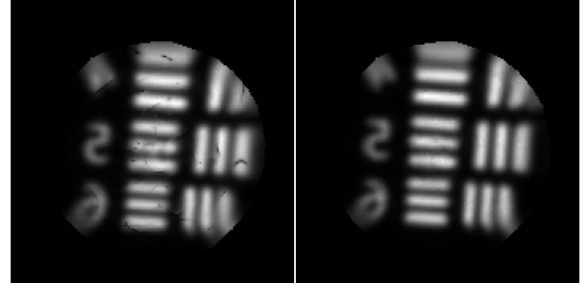
Fig. 3 :Endoscopic imaging of USAF target. System calibrated with 1 (left) and 5 (right) internal